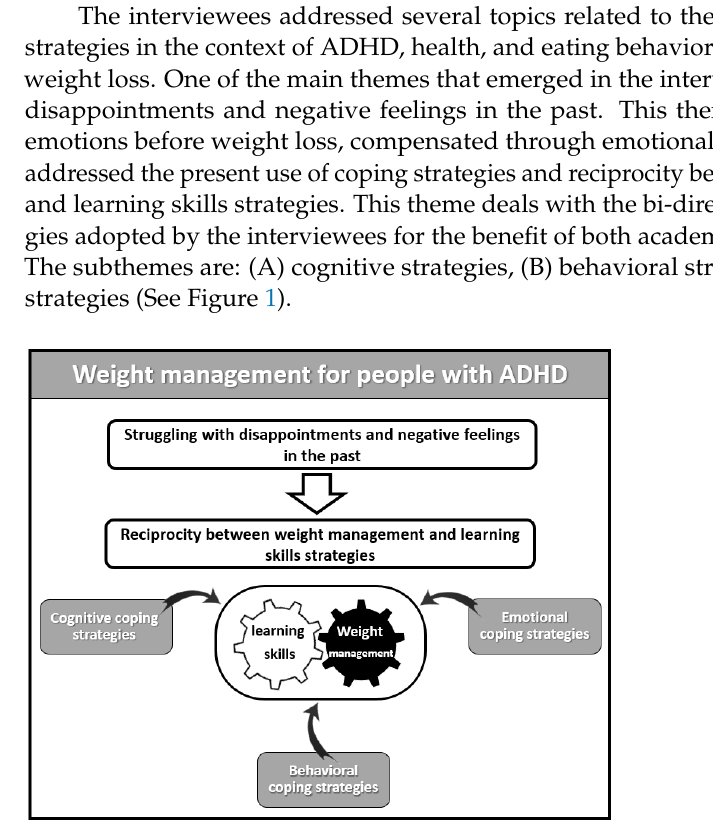
Figure 1. Outline of themes and